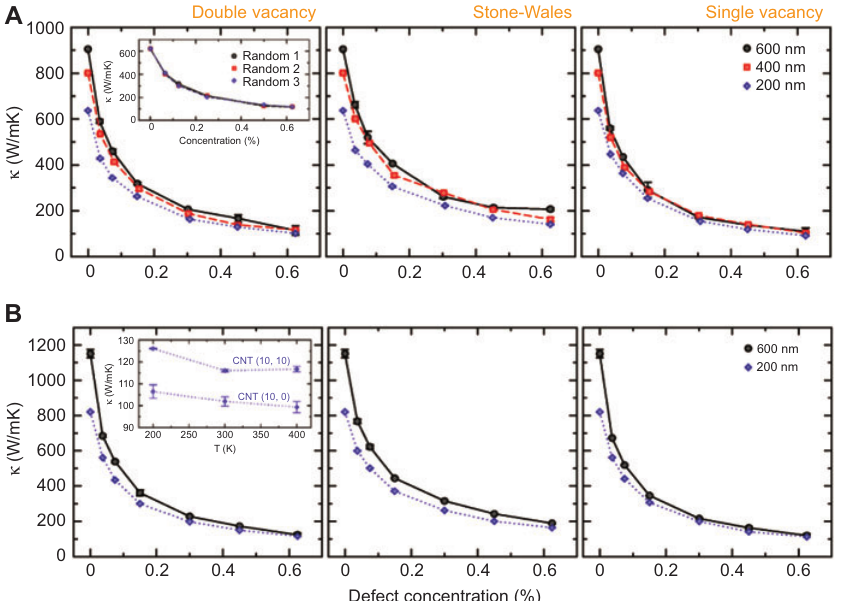
Figure 1 Evaluation of NEMD lattice thermal conductivity with defect concentration for (A) carbon nanotube (CNT)(10, 0) and (B) CNT(10, 10) containing randomly distributed single vacancy, double vacancy, and Stone-Wales type defects. The symbols, black circle, red square, and blue diamond, represent different lengths, 200, 400, and 600 nm, respectively. The insets in (A) and (B) show thermal conductivity ( k ) values for three different randomly defected CNT (10,0) structures and the effect of temperature on 0.625 % defected CNTs, respectively. At low defect concentrations ( d < 0.1 % ), k decreases very fast with increasing defect concentrations. At high concentrations ( d > 0.25 % ), k decreases quite slowly with increasing d , approaching very similar values for both armchair and zigzag CNTs and for all types of defects. (Reproduced from Ref. [32] with permission from the American Chemical